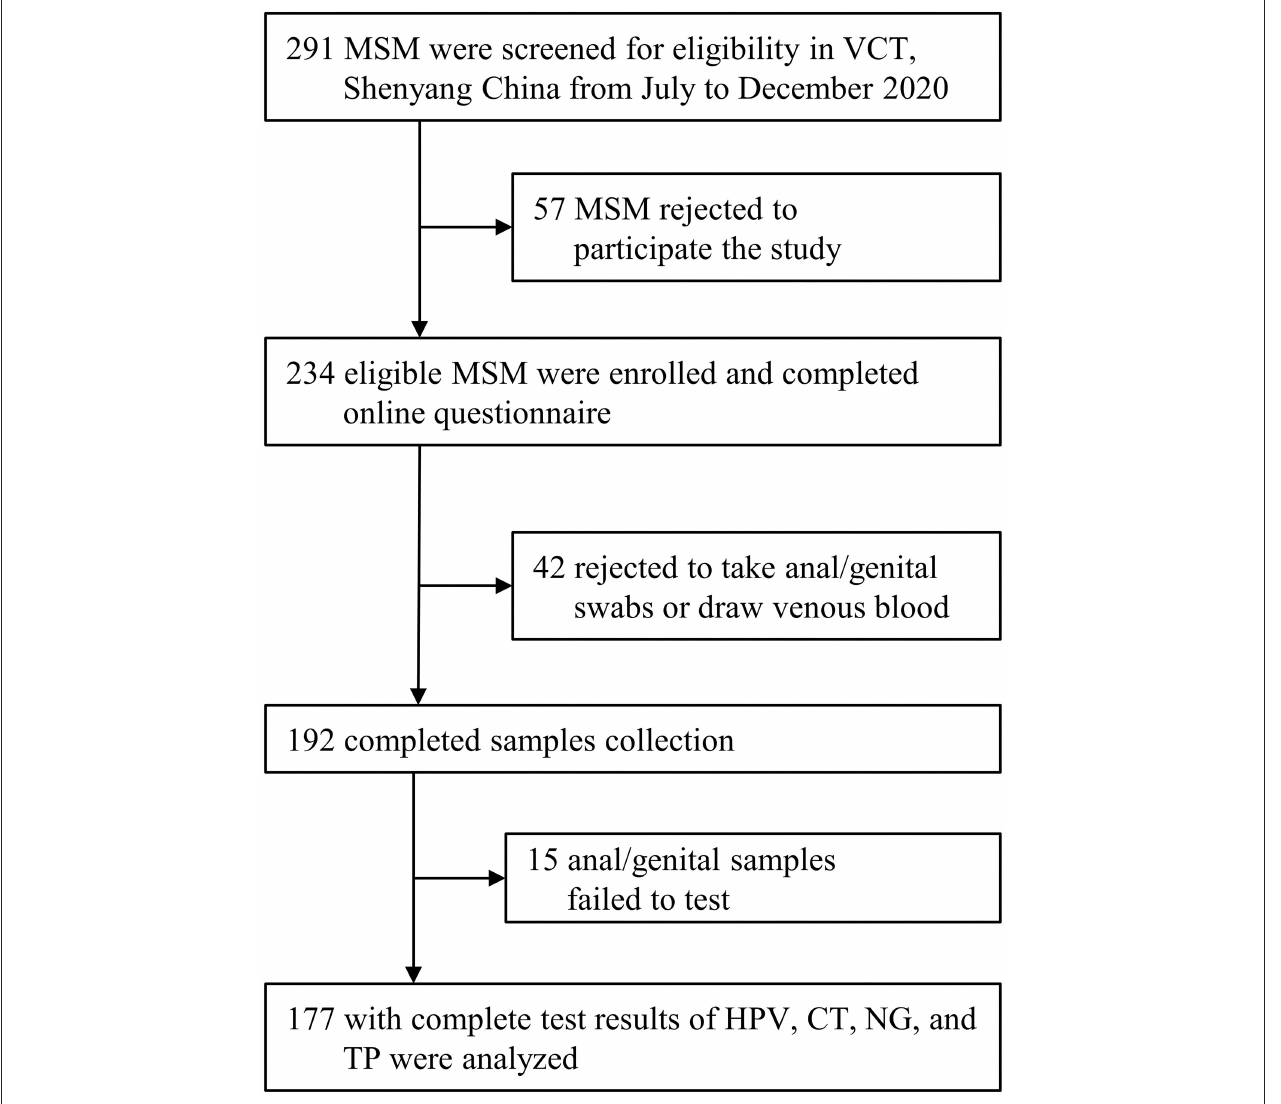
FIGURE 1 | Inclusion flowchart. VCT, voluntary counseling and testing; HPV, human papillomavirus; CT, Chlamydia trachomatis ; NG, Neisseria gonorrhoeae ; TP, Treponema pallidum